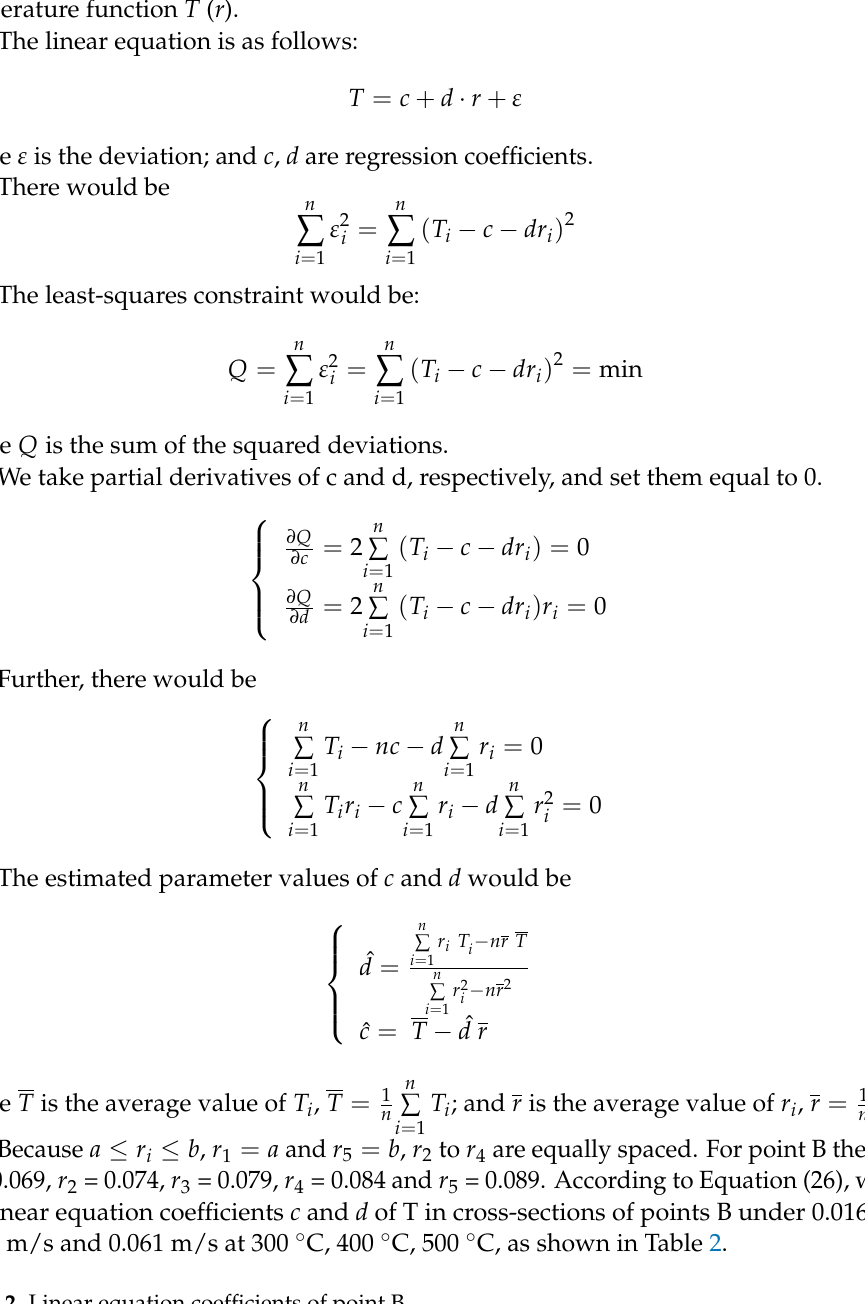
Table 2. Linear equation coefficients of point